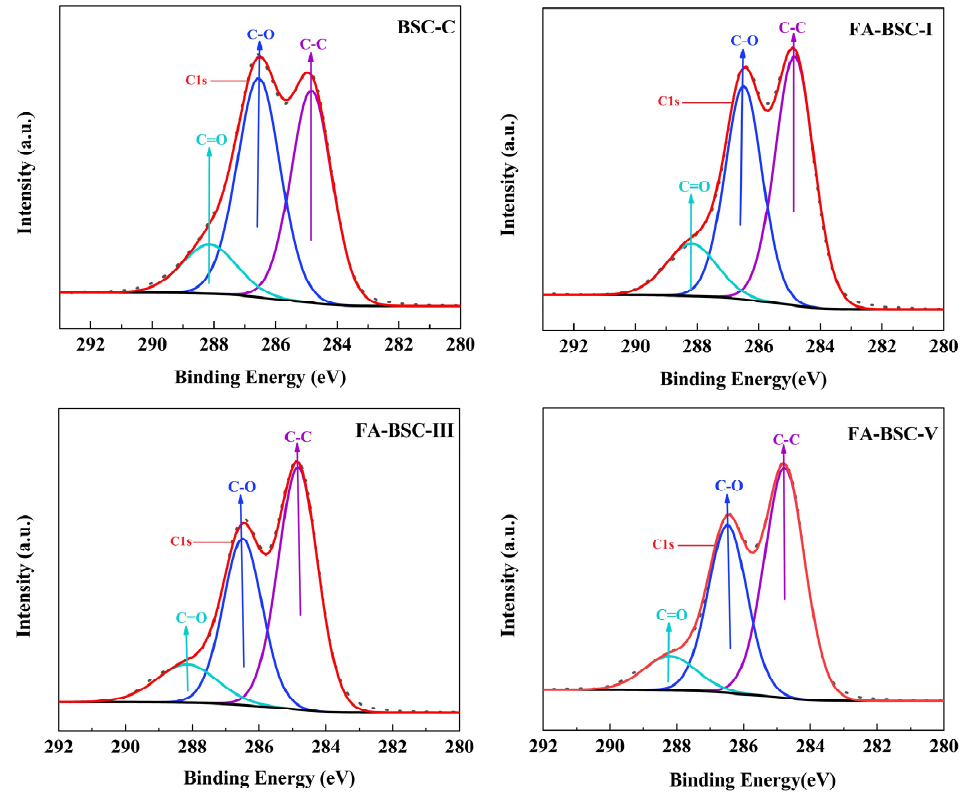
Figure 5. XPS spectra of C peaks in untreated and furfurylated BSCs.